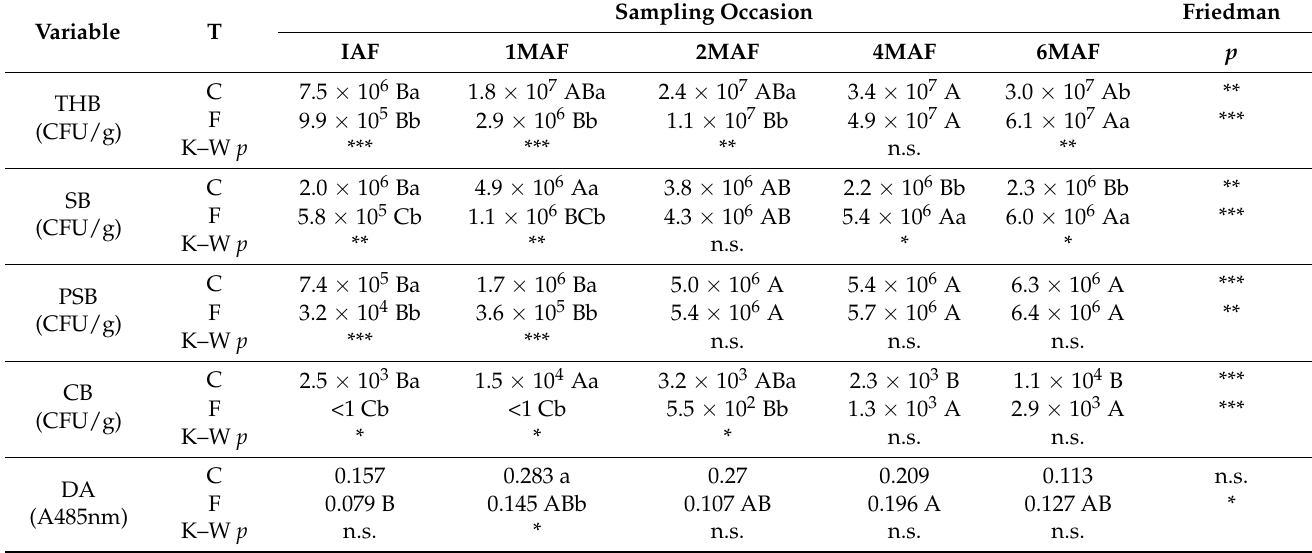
Table 4. Soil total heterotrophic bacteria (THB), sporogenic bacteria (SB), phosphate-solubilising bacteria (PSB), carbapenem-resistant bacteria (CRB), and dehydrogenase activity (DA) in control (C), and fire (F) treatments (T) during the studied period (IAF, immediately after fire; MAF, months after fire) (mean values). Different letters indicate significant differences between sampling dates (uppercase letters) and treatments (lowercase letters). Kruskal–Wallis (K-W) (* p < 0.05, ** p < 0.01, *** p < 0.001, and n.s. non-significant at p < 0.05) results are shown for each comparison between treatments, and Friedman ANOVA between sampling